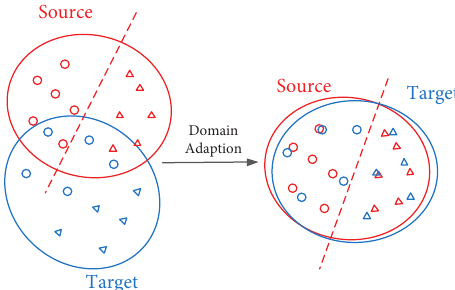
Figure 1: Schematic diagram of domain